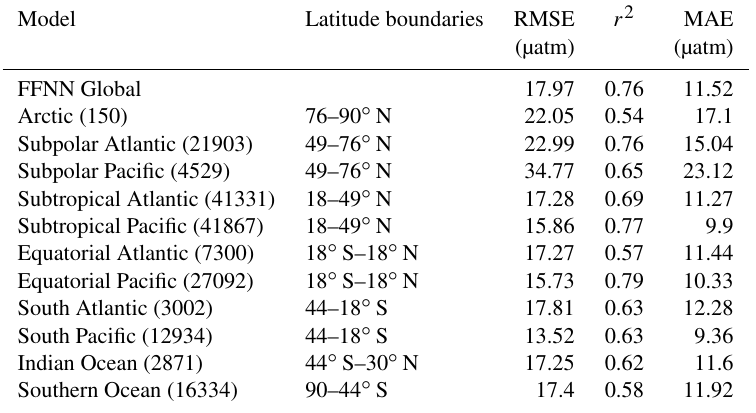
Table 1. Statistical validation of LSCE-FFNN. Comparison between reconstructed surface ocean p CO 2 and p CO 2 values from the SOCAT v5 database not used in the training algorithm for the period from 2001 to 2016 over the global ocean (except for regions with ice cover) and for large oceanographic regions. The number of measurements per region is given in parentheses in the first column. Model Latitude